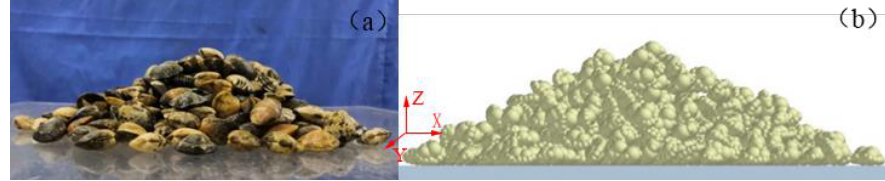
Figure 4. Clam stacking test: ( a ) direct measurement ( b ) DEM simulation test.